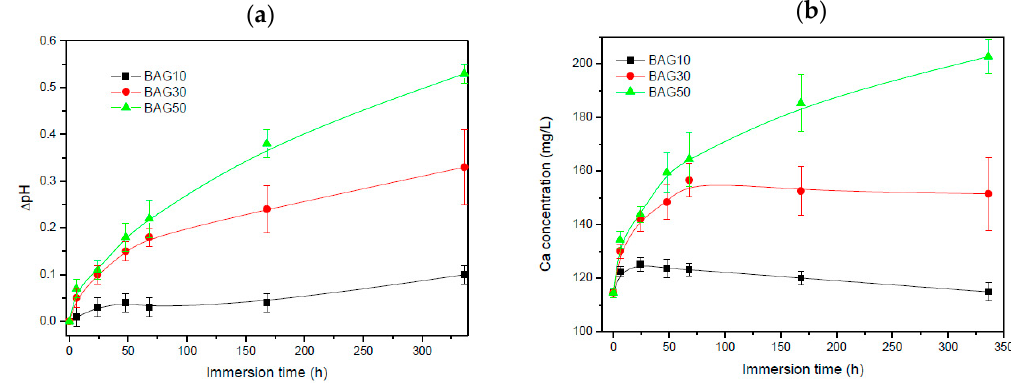
Figure 4. Change in pH ( a ) and in Ca concentration ( b ) in the simulated body fluid (SBF) solution as a function of immersion time.